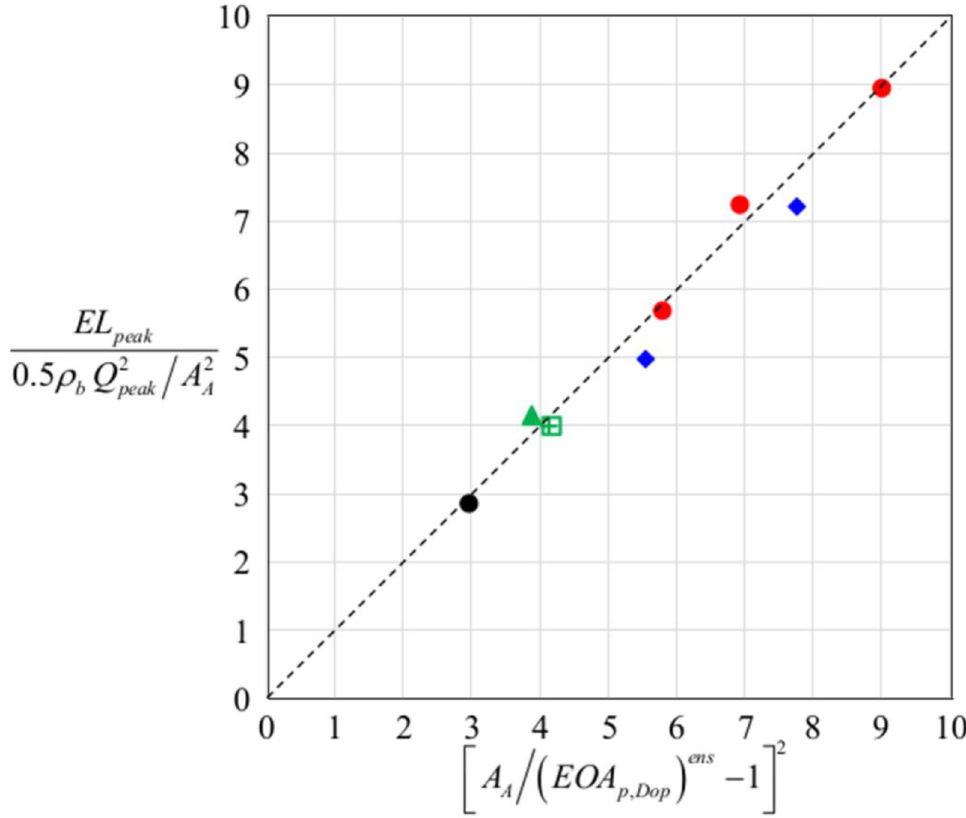
Fig 12. Left and right hand sides of Eq (7) for the cases considered in present study. No pannus (black circle); circular panni with h = 0.12 D , 0.13 D and 0.14 D (red circles); upper semi-circular pannus with h = 0.12 D (green triangle); right and left semi-circular panni with h = 0.12 D (green square and cross symbols, respectively); and restricted opening angles of 15˚ and 20˚ (blue